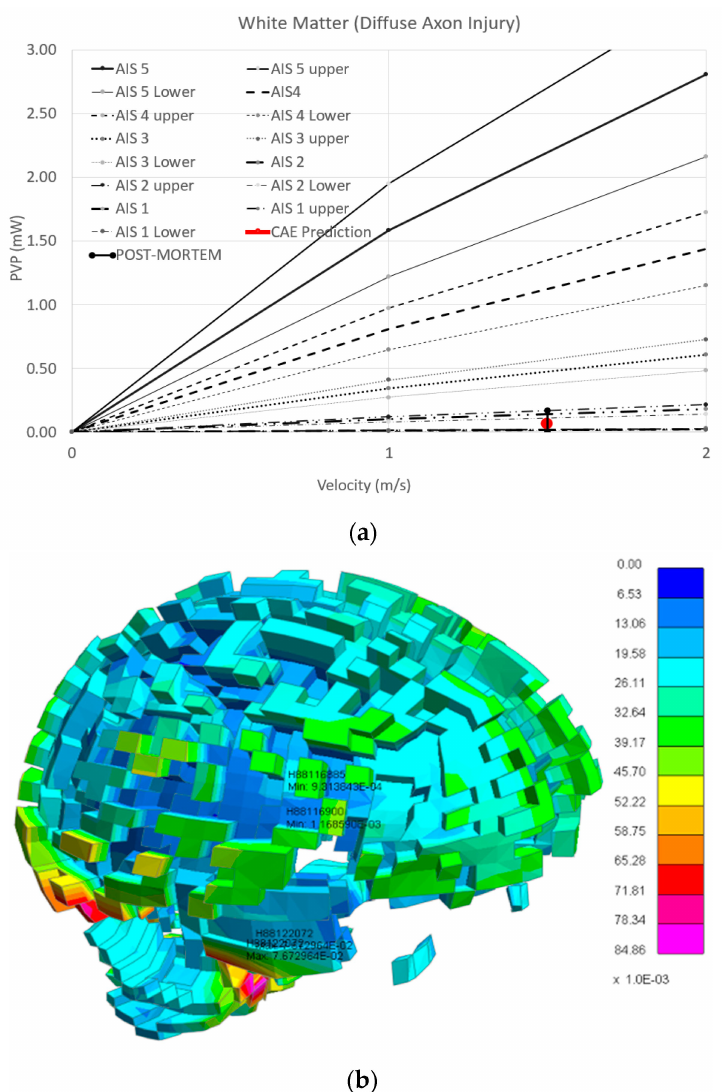
Figure 13. Parietal White Matter OTM Model. ( a ) Parietal white matter trauma prediction, ( b ) Maximum Principal strain (white